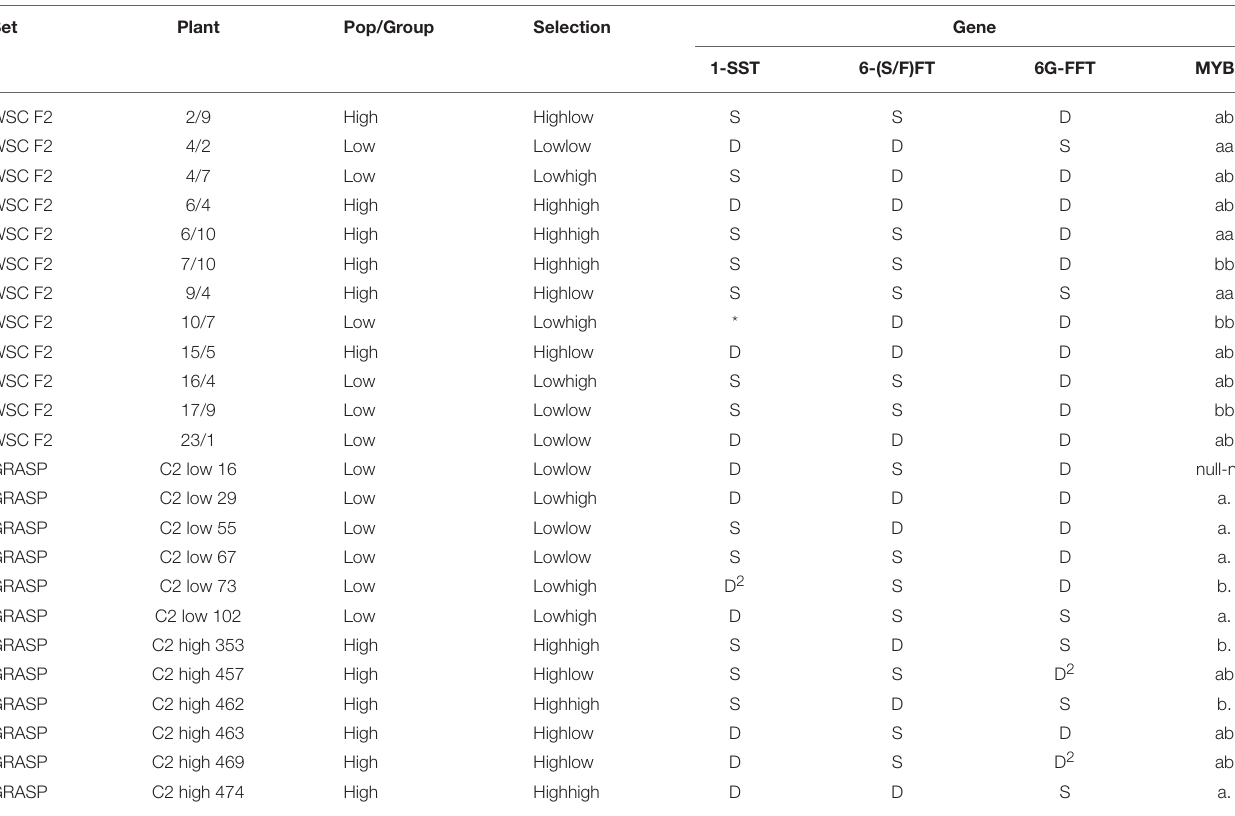
TABLE 6 | Genetic studies on selected candidate genes. Set